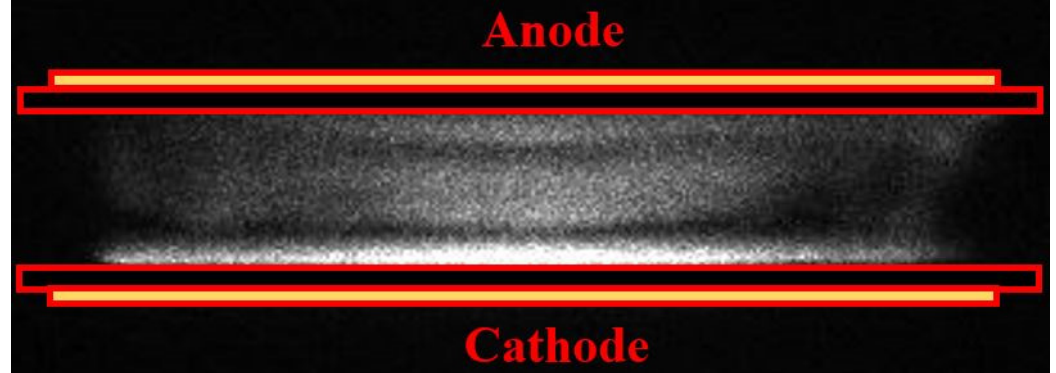
Figure 4. The intensified CCD (ICCD) photograph is taken with the 1 μ s exposure time during the breakdown to confirm the discharge uniformity.